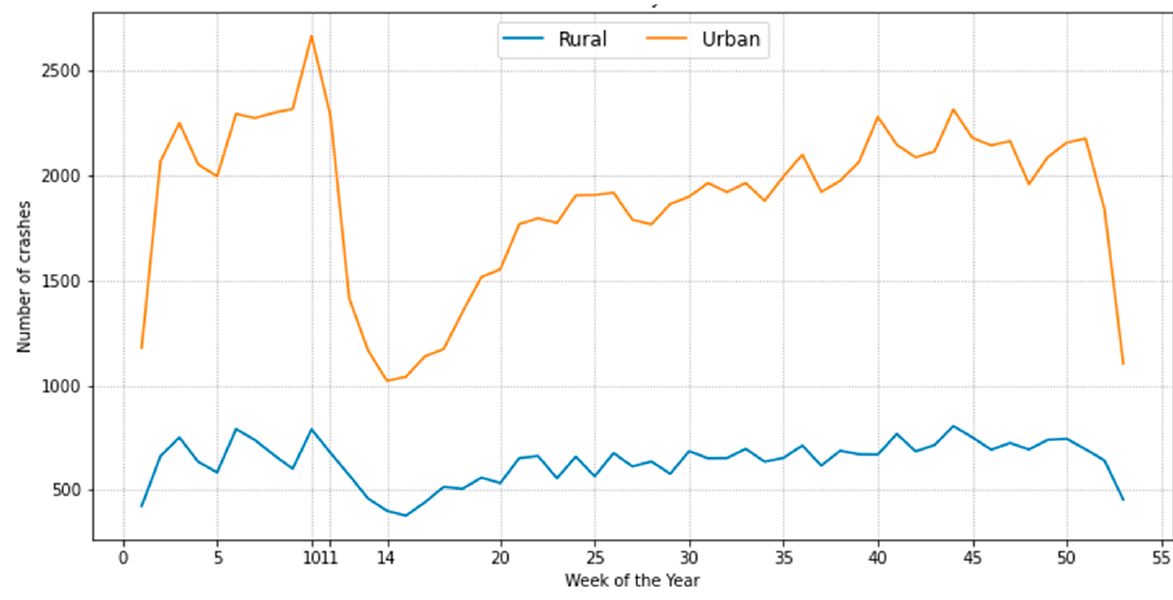
Figure 1. Distribution of total crashes by week of the year.